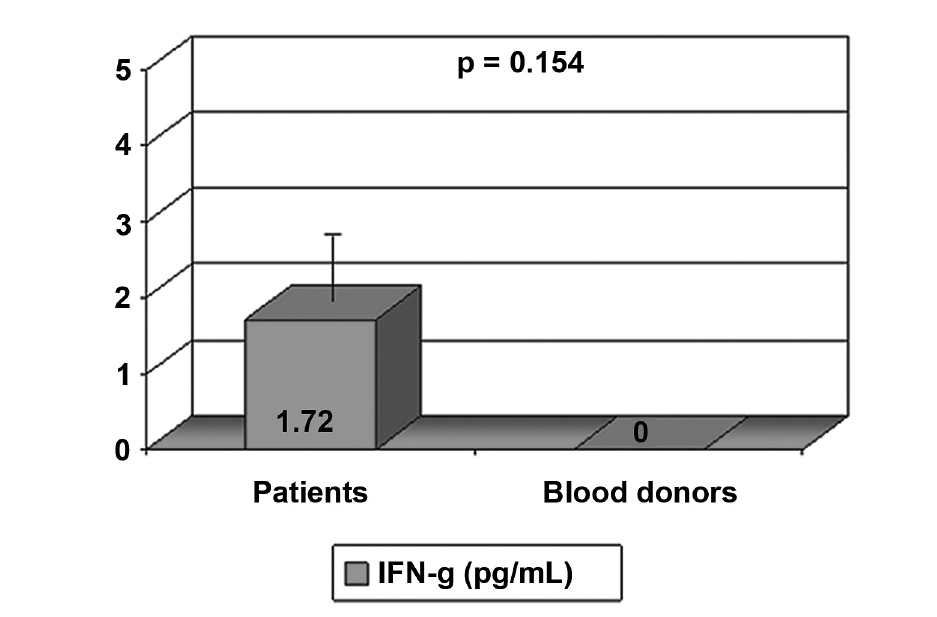
Figure 2 – IFN-γ serum levels in PD patients and healthy blood